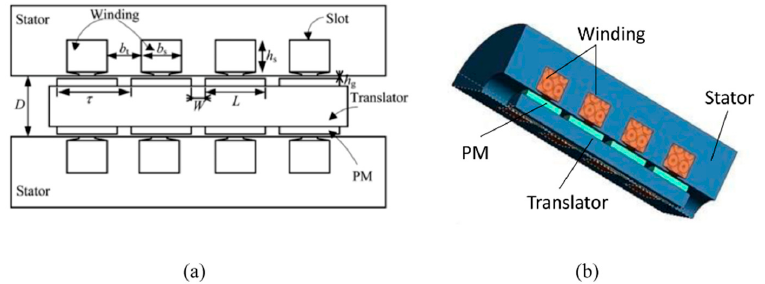
Figure 11. Linear alternator at Shanghai Jiaotong University [36]. ( a ) Cross-sectional view of flat-type FPLG; ( b ) Model of tubular linear alternator.